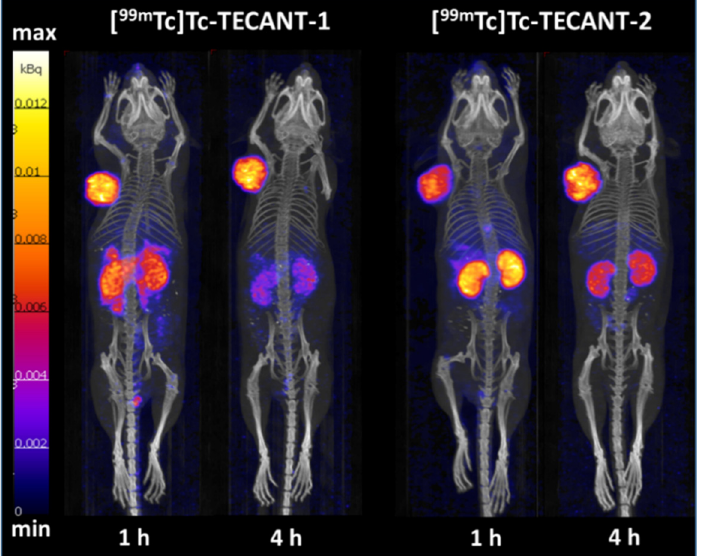
Figure 4. Head-to-head SPECT/CT images of [ 99m Tc]Tc-TECANT-1 and [ 99m Tc]Tc-TECANT-2 (200 pmol/5–6 MBq) in nude mice bearing HEK-SST2 (+) xenografts at 1 and 4 h p.i.